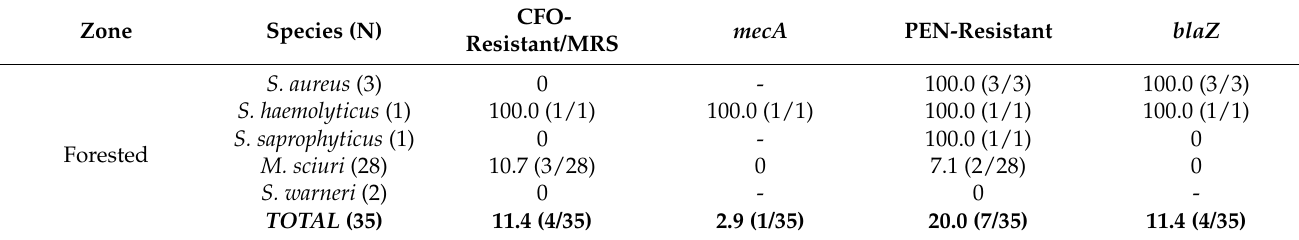
Table 3. Distribution of cefoxitin (CFO)-resistant/methicillin-resistant Staphylococcaceae (MRS), peni- cillin (PEN)-resistant isolates and detection of mecA and blaZ genes according to study zones. Zones are arranged from the lowest to the highest degree of